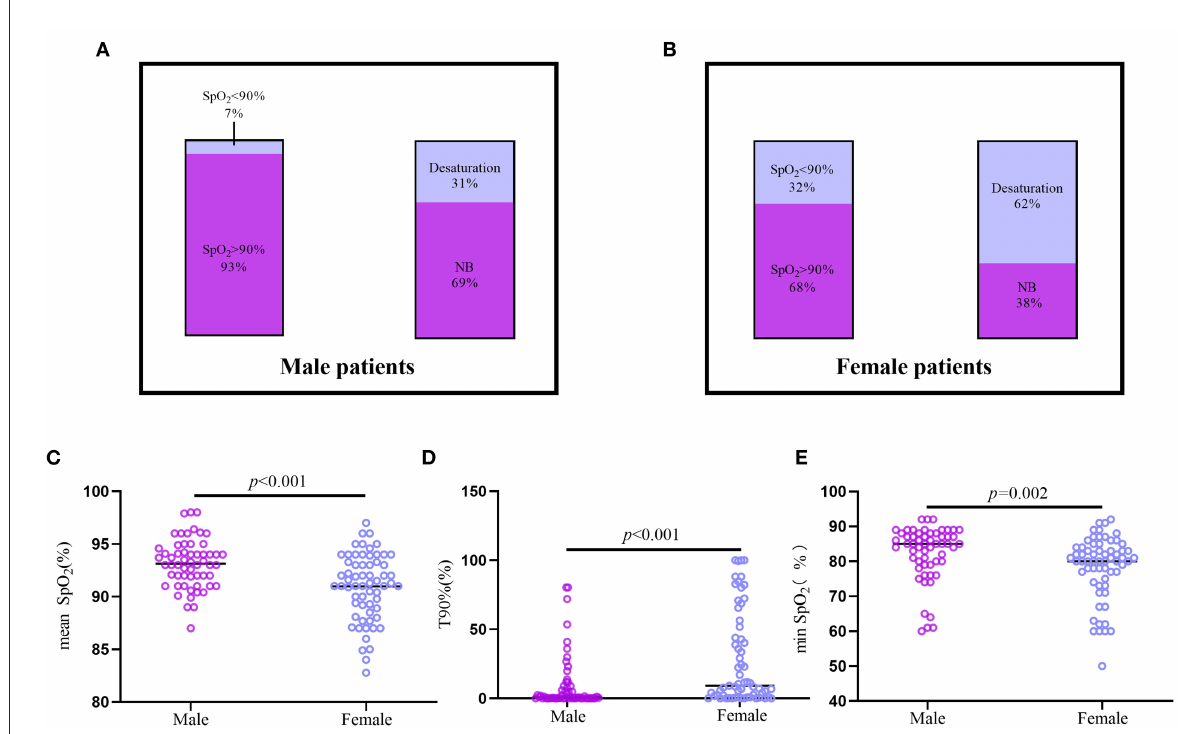
FIGURE3 The difference of nocturnal hypoxemia between Male and Female patients with CTEPH and CTEPD. (A,B) The prevalence of nocturnal hypoxemia and desaturation in male ( n = 57) and female ( n = 63) patients. (C–E) Male CTEPH patients had higher mean SpO 2 , min SpO 2 and lower T90% than the female CTEPH patients. CTEPD, chronic pulmonary thromboembolic disease; CTEPH, chronic thromboembolic pulmonary hypertension; mean SpO 2 , nocturnal mean SpO 2 ; min SpO 2 , minimal SpO 2 ; T90%, the ratio of nocturnal SpO 2 below 90% of the total monitoring